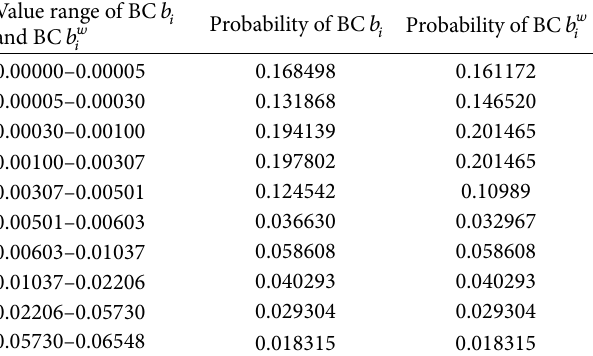
Value range of BC 𝑏 and BC 𝑏 𝑤